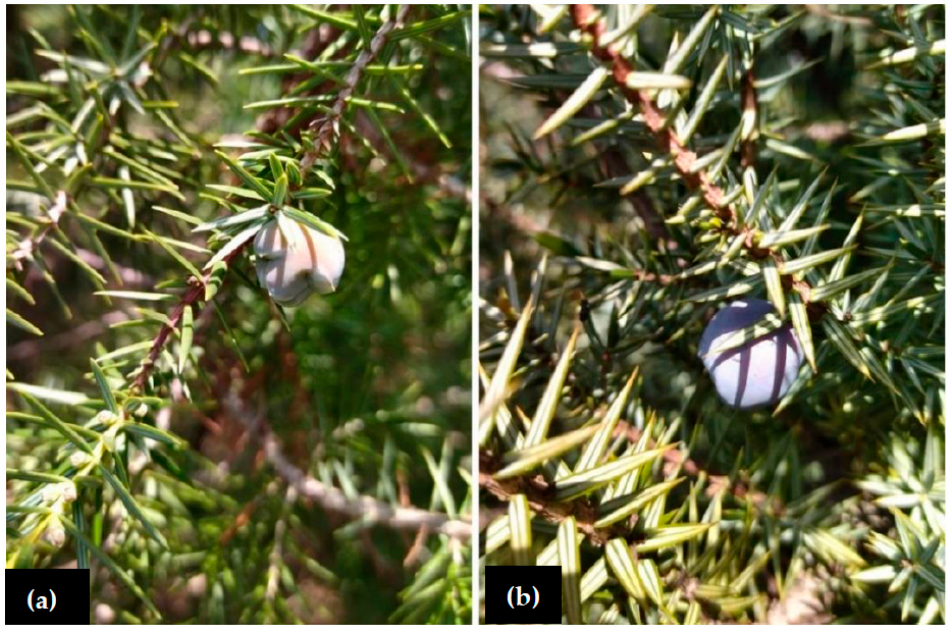
Figure 1. ( a ) Juniperus oxycedrus L. and ( b ) J. macrocarpa